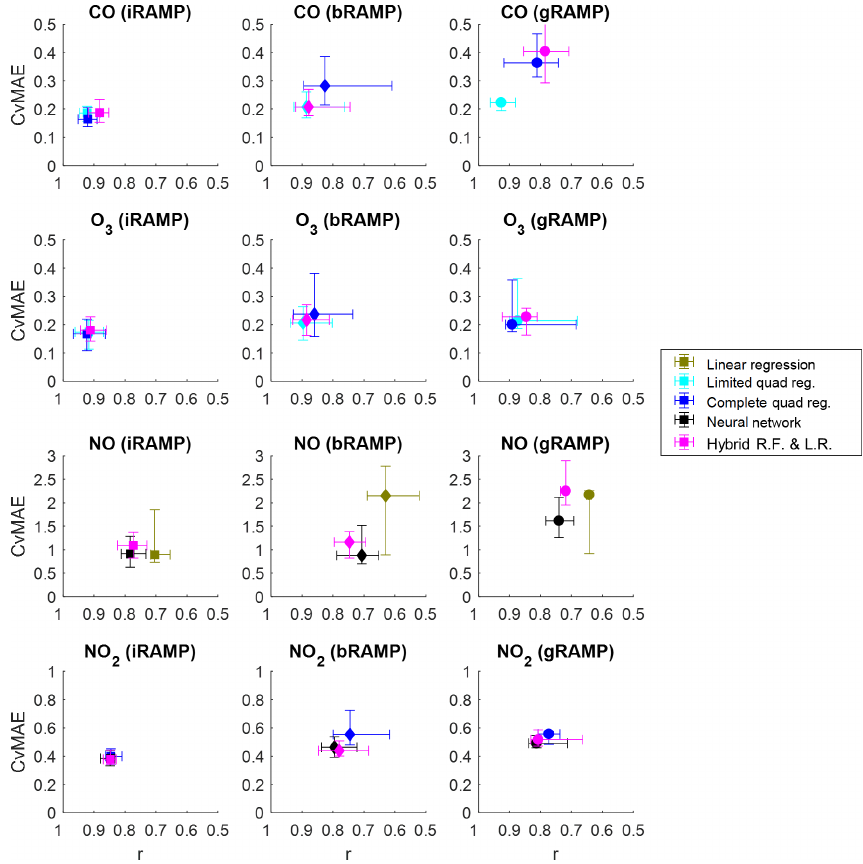
Figure 3. Comparative performance of individualized (iRAMP – square), best individual (bRAMP – diamond), and general (gRAMP – circle) model categories across gases measured by the RAMPs. The modeling algorithms used for each gas correspond to three of the better- performing algorithms identified among the individualized models. Models are trained and tested on distinct subsets of collocation data collected at the CMU site during 2017; performance shown is based on the testing data set only. Proximity to the lower-left corner of each figure indicates better